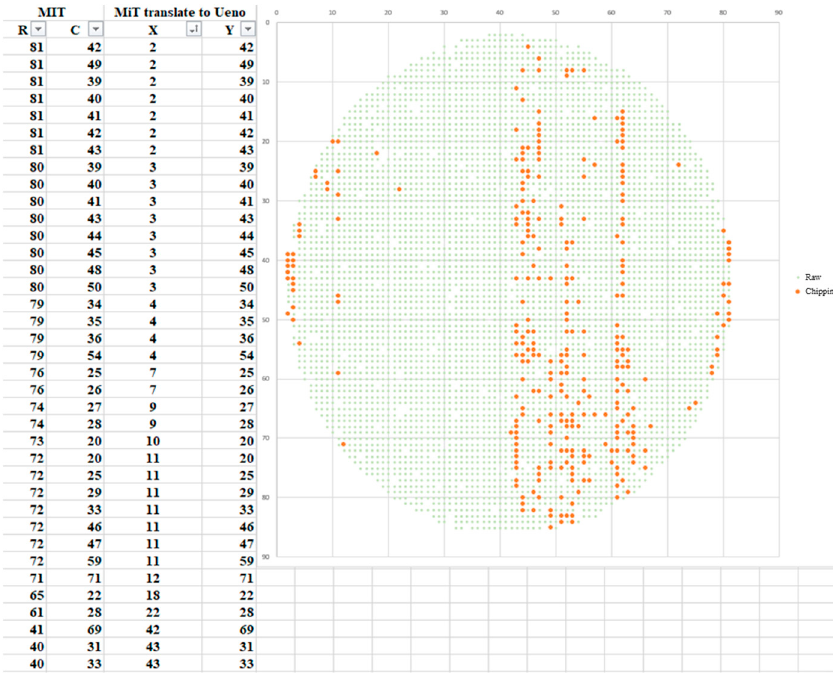
Figure 8. A sample wafer chipping.